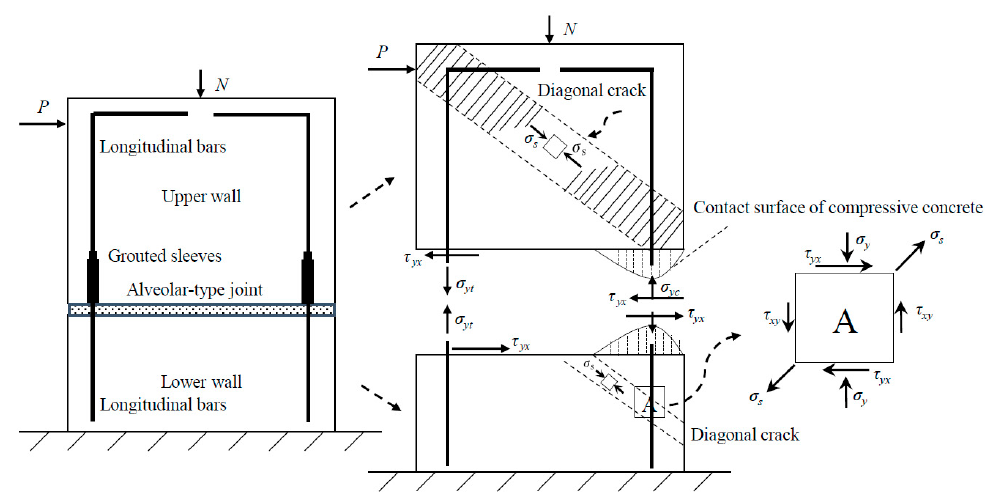
Figure 6. The force diagram of the PC wall.